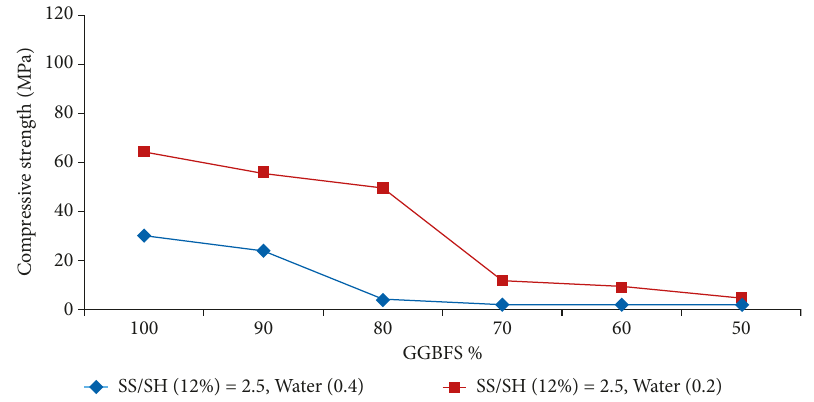
Figure 4: The impact of superplasticiser and low water amount on compressive strengths at 7 curing